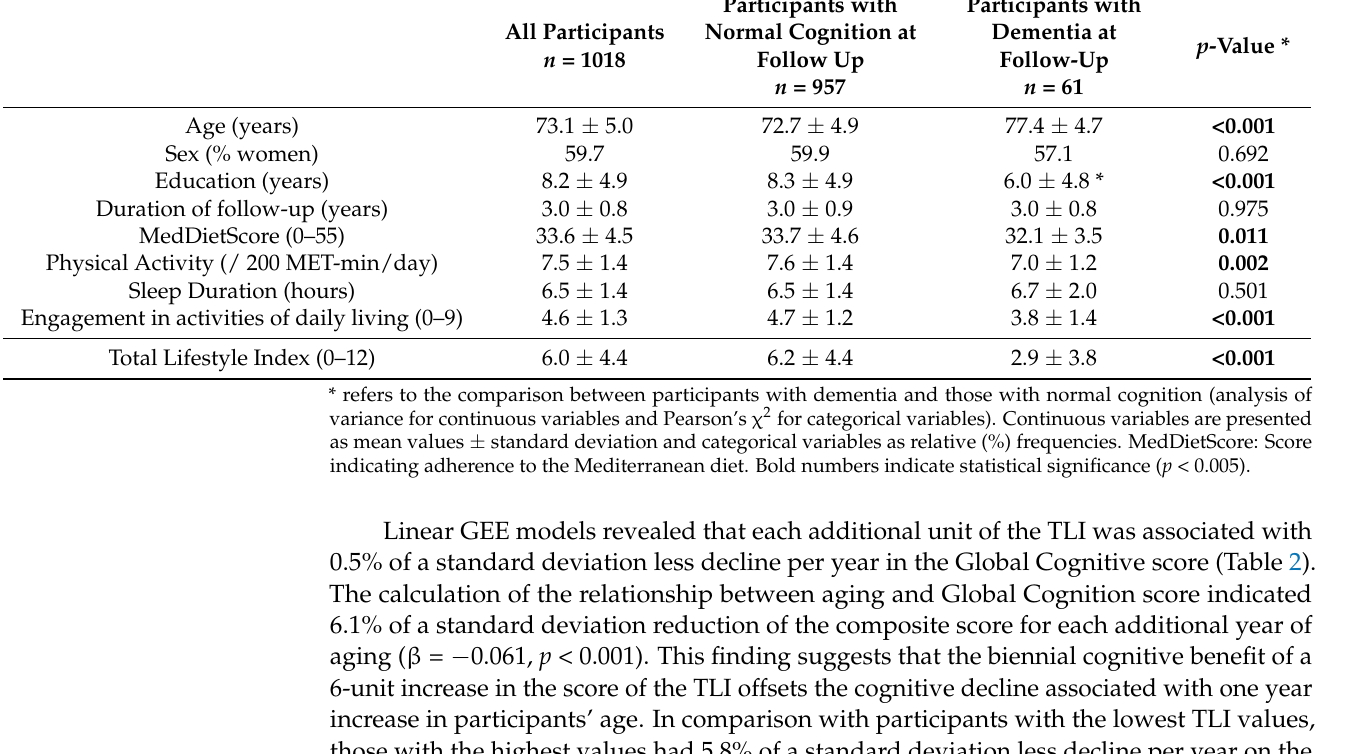
Participants with Dementia at p -Value Follow-Up n = 61